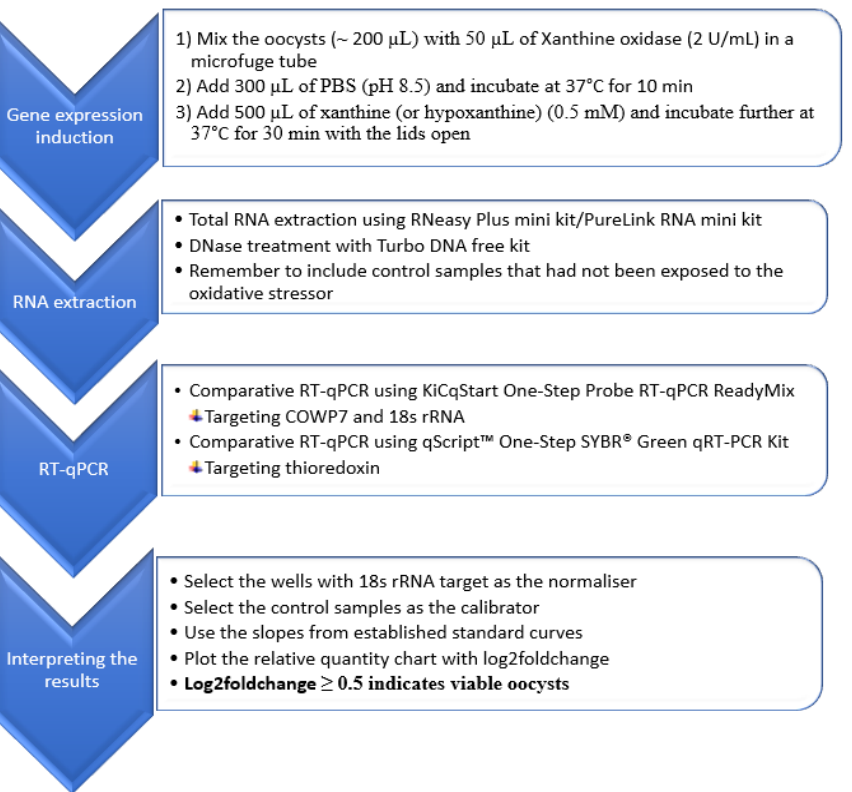
Figure 2. Flow chart representing the summary of the comparative RT-qPCR method for the assess- ment of viability of Cryptosporidium